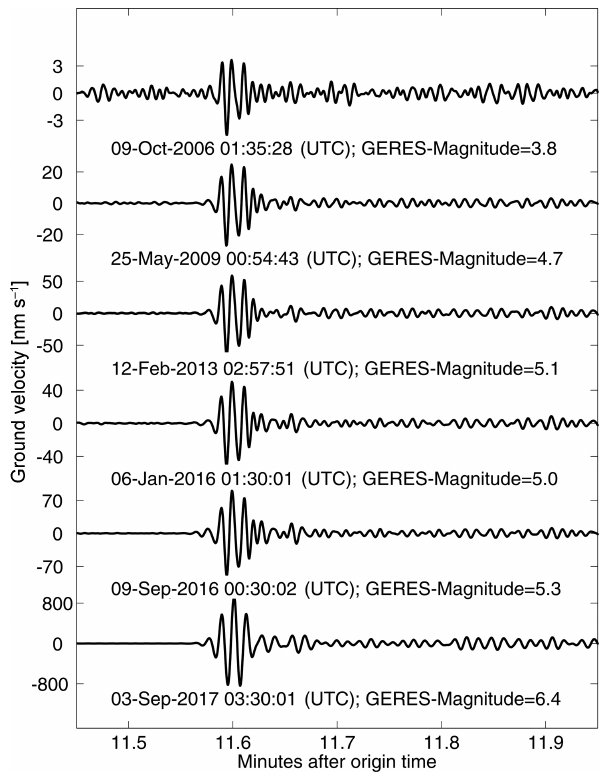
Figure 9. Beam seismograms calculated from the vertical compo- nents of the GERES array showing the P wave of the six North Korean nuclear explosions. The seismograms are normalized to the individual maximum amplitudes, for which the station magnitude is estimated.